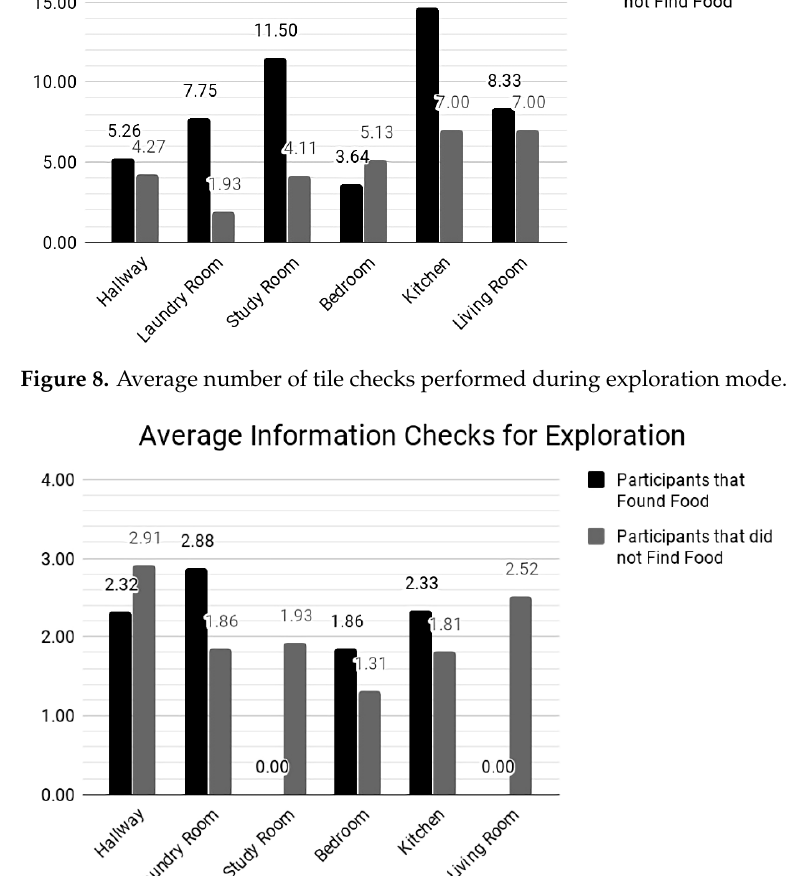
Figure 9. Average number of information checks performed during exploration mode.